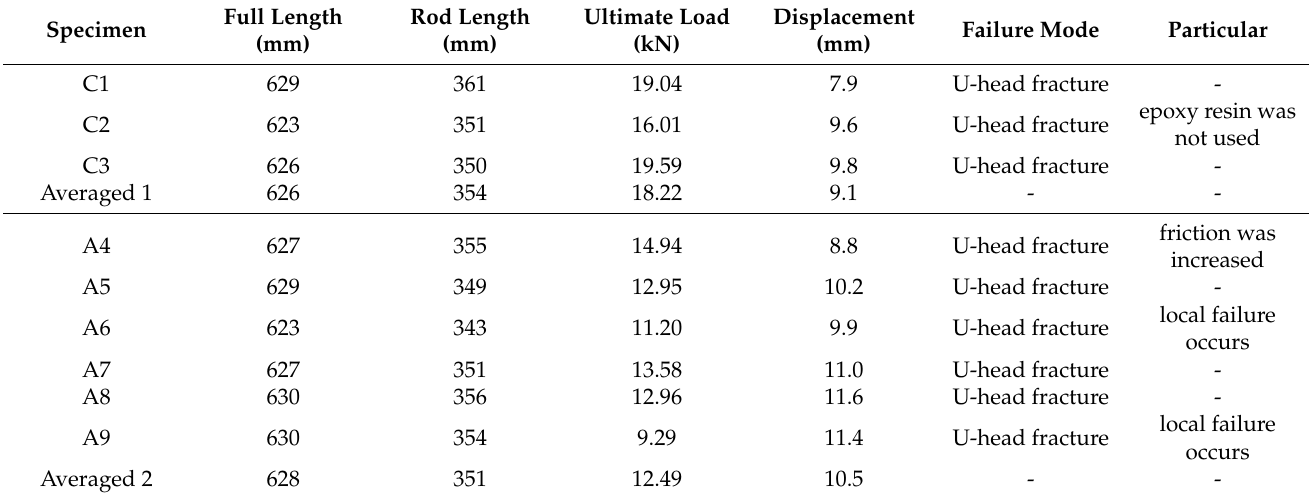
Figure 8. ( a ) Positions of eight strain gages on the surface of the BFRP tendon specimen; ( b ) the entire test set-up for tensile test. Table 2. Summary of tensile test on nine